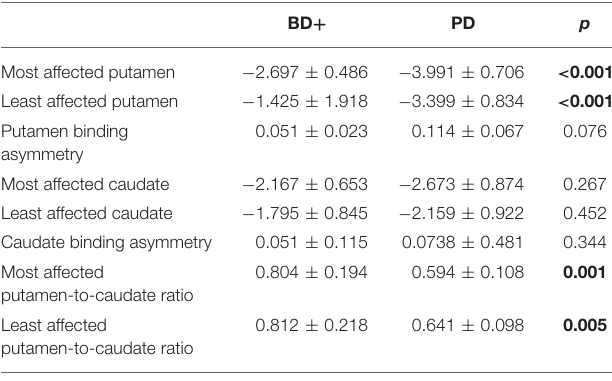
TABLE 2 | Comparisons of DaT binding values ( z scores) between BD patients with abnormal DaTSCAN (BD + ) and PD patients.